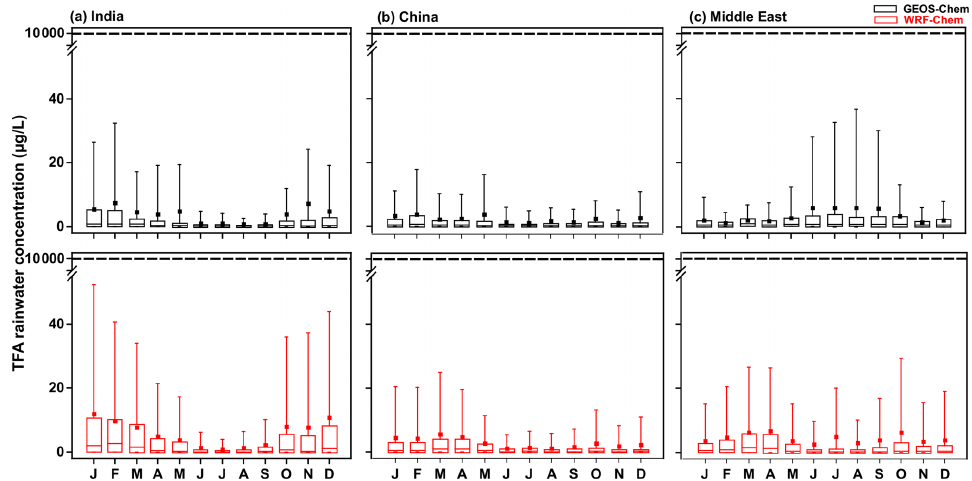
Figure 9. Box and whisker plot of TFA rainwater concentration calculated from GEOS-Chem and WRF-Chem in the three domains. In the box plot, the inside line and square are the median and mean, respectively. Box boundaries are the 25th and 75th percentiles, and whiskers indicate the 5th and 95th percentiles. The dashed horizontal line is the no observable effect concentration (NOEC) level. It is important to note that these values, including the 95th percentile values, are at least 100 times lower than the NOEC for harming aquatic bodies, even when normalized for higher projected emissions in 2040.